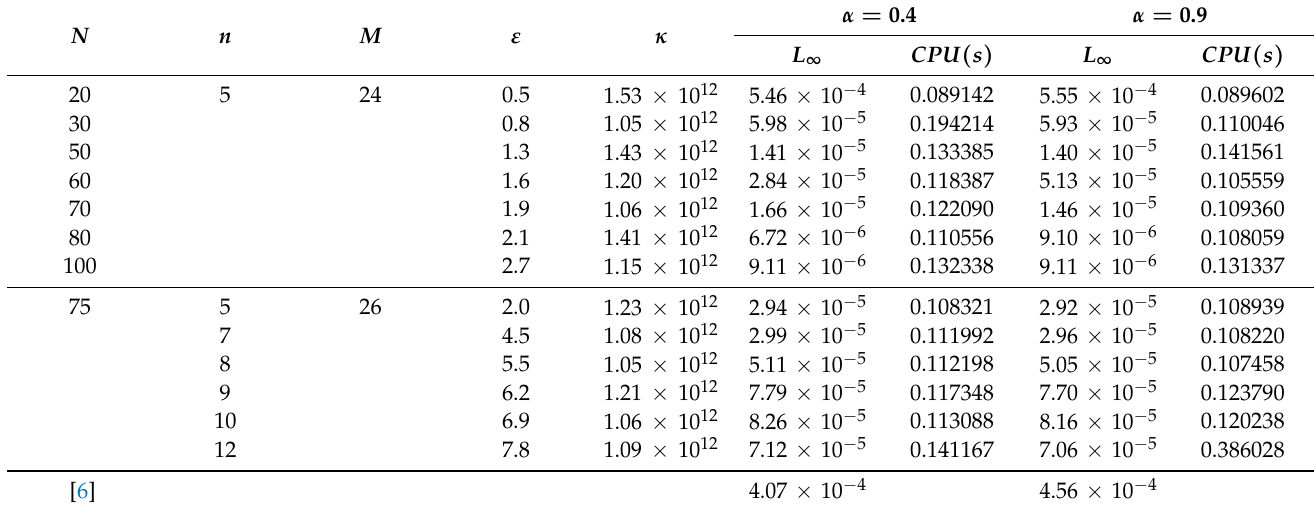
Table 1. The approximate solutions with γ = 0.1, ξ ∈ [ 0,1 ] , and t = 1, corresponding to Problem